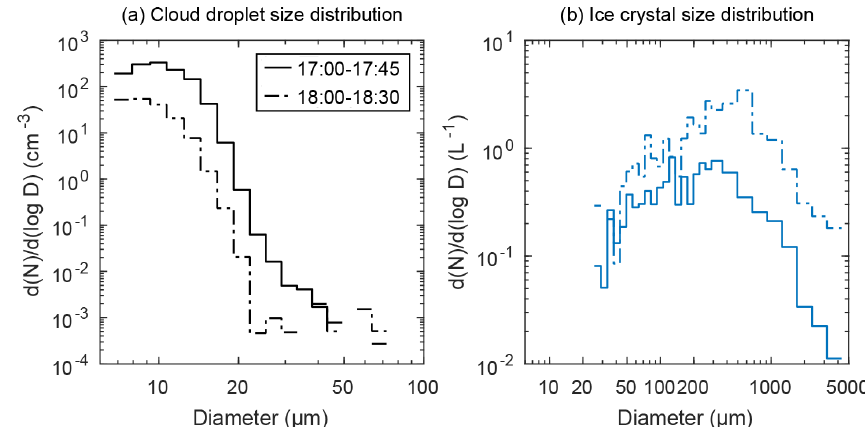
Figure 7. Cloud droplet (a) and ice crystal (b) size distributions observed with the HoloBalloon platform. The size distributions were averaged between 17:00 and 17:45UTC (solid line) and between 18:00 and 18:30UTC (dashed line).